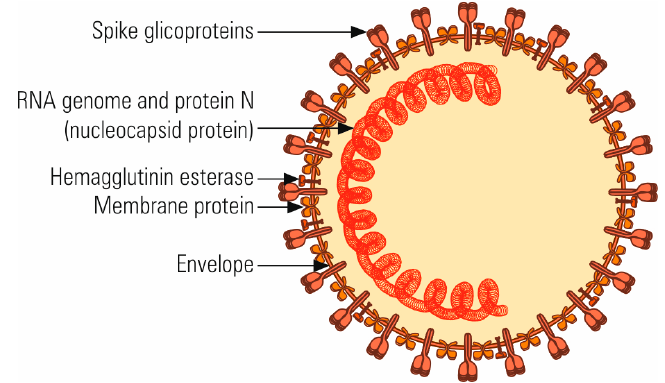
Figure 1. Schematic representation of virion molecular structure. The S spikes are most prominent on the virion surface and confer the specific appearance of corona. The transmembrane M protein is highly hydrophobic, with three domains in the peplos. The E glycoprotein is a minor constituent of peplos. Some coronaviruses have an additional protein, HE (haemagglutinin-esterase).